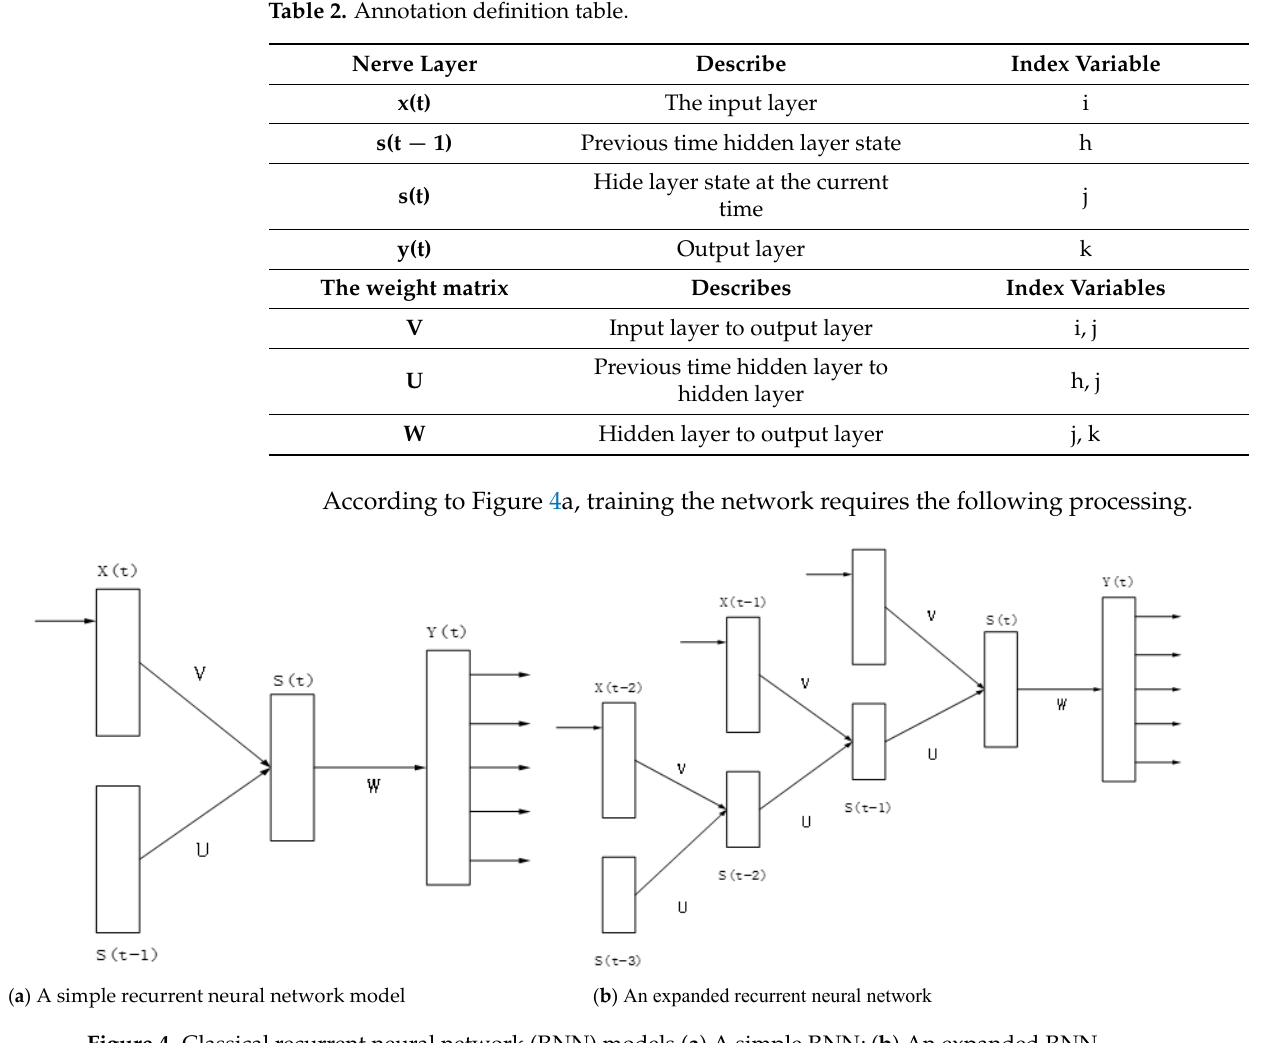
Figure 4. Classical recurrent neural network (RNN) models ( a ) A simple RNN; ( b ) An expanded RNN. The input layer → the hidden layer. As shown in Equations (3) and (4):